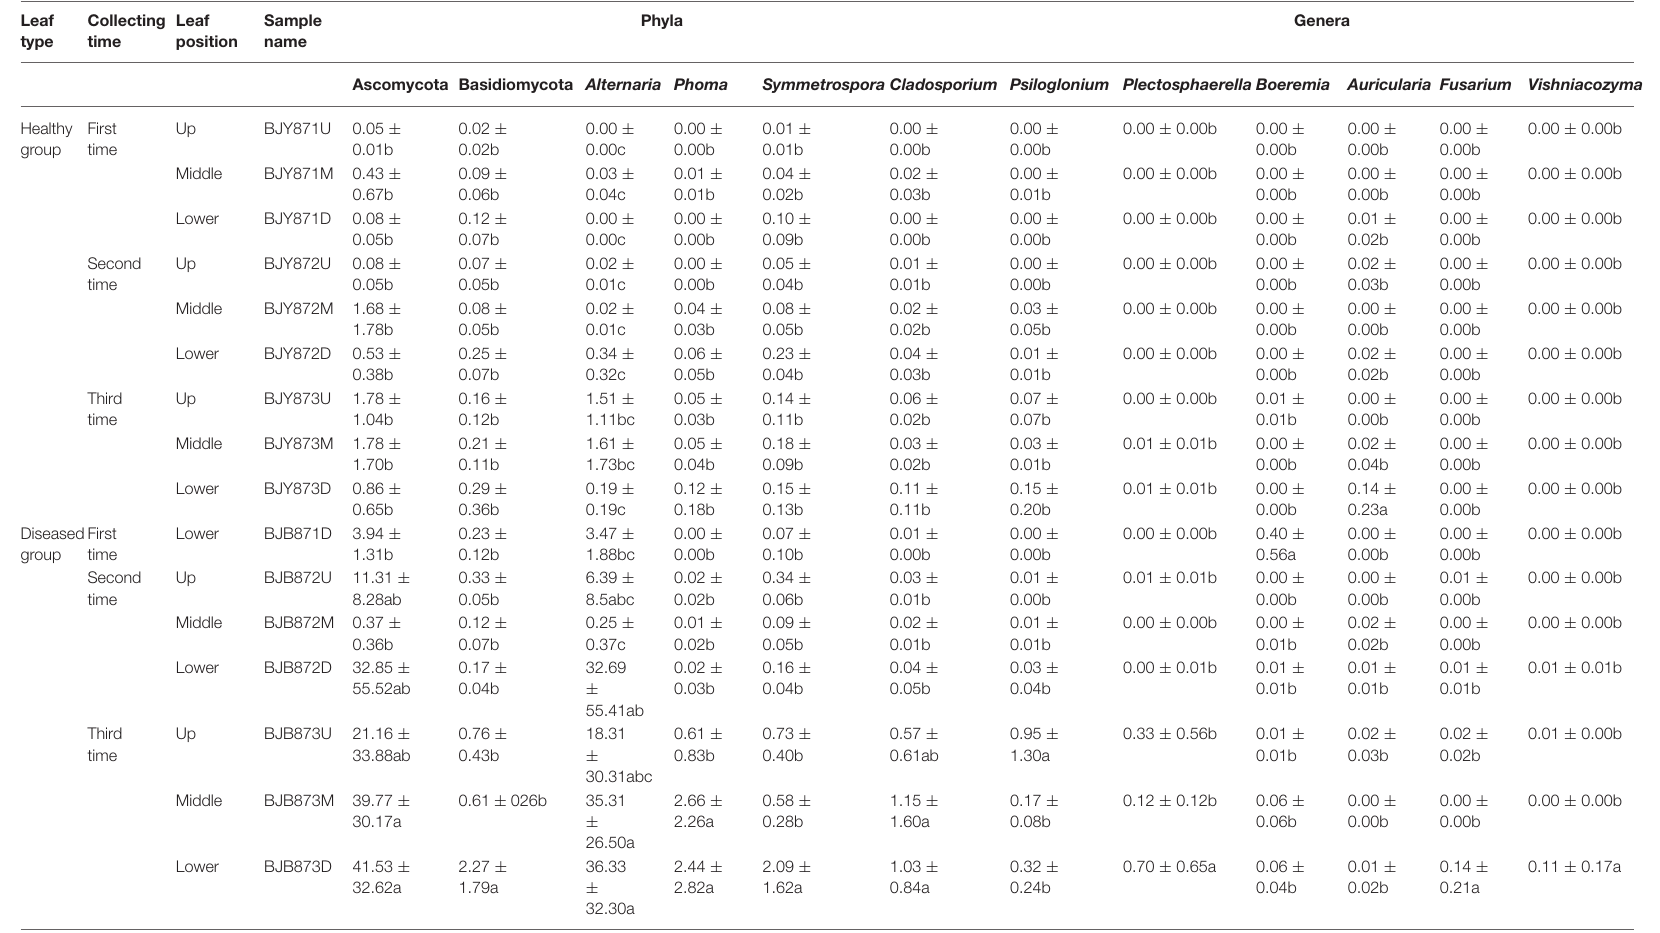
TABLE 3 | Community compositions and relative abundance of phyllosphere microorganism from tobacco leaves infected by Alternaria alternata at fungal phyla and genera levels (%).